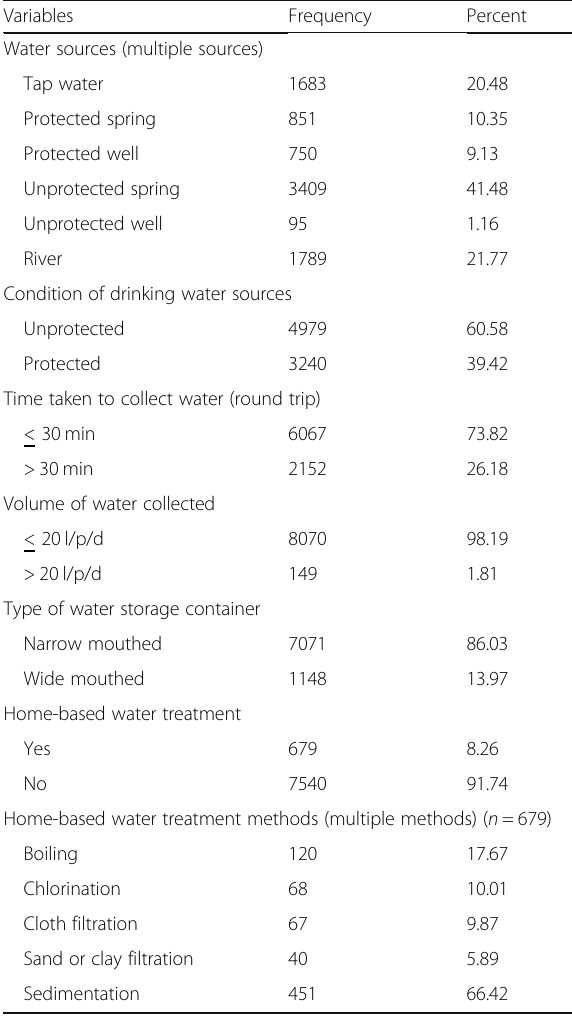
Table 3 Drinking water sources and home water handling among households in DHDSS sites, Dabat, northwest Ethiopia,